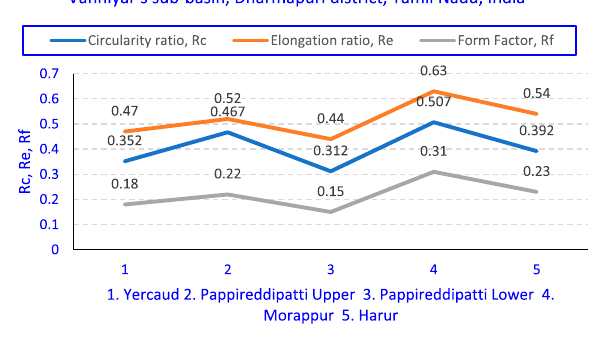
FIGURE 10 | Plot of relation between drainage density, D d and stream frequency, F s .